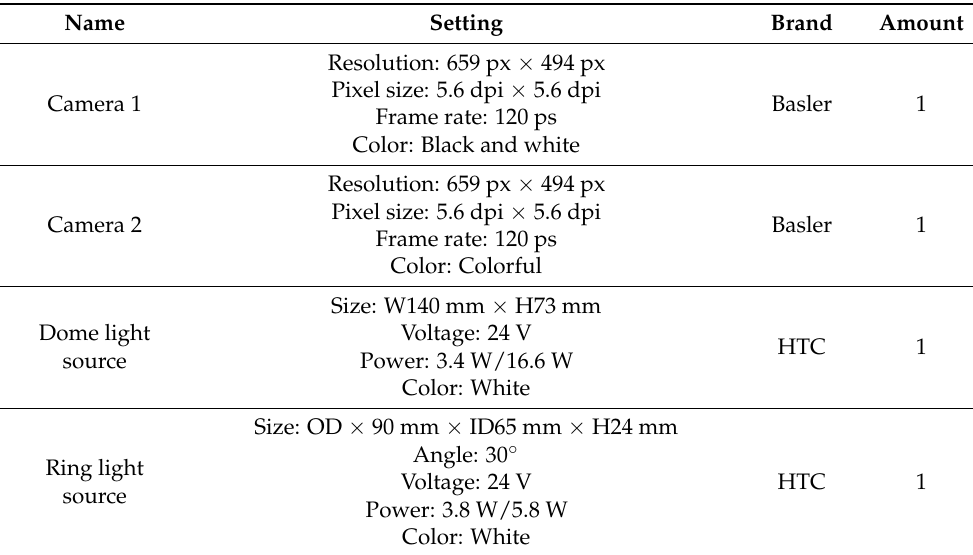
Table 4. Detailed parameters for each